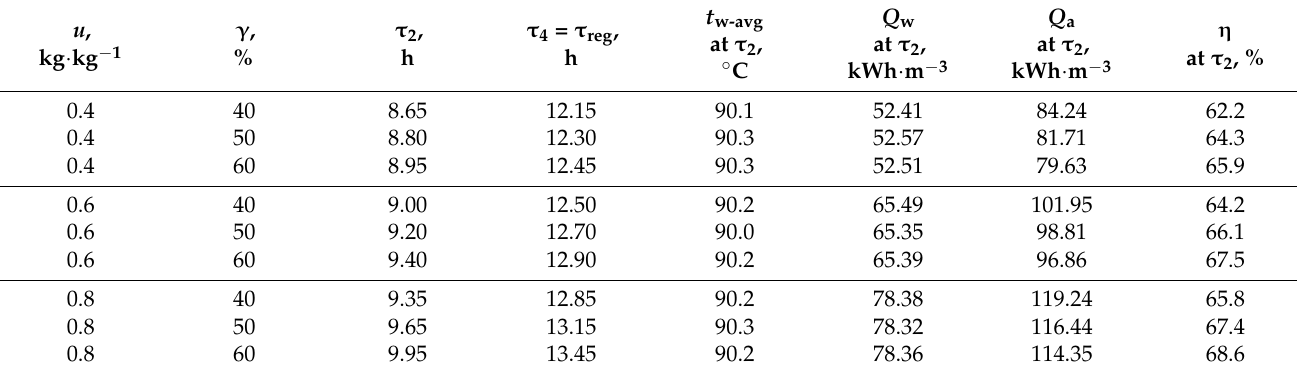
Table 3. Change in the Energy Efficiency η of the Regimes for Autoclave Steaming at t m1 = 130 °C of Beech Prisms with t wo = 0 °C and d × b = 0.4 × 0.4 m, Depending on Moisture Content u and Loading Level γ .